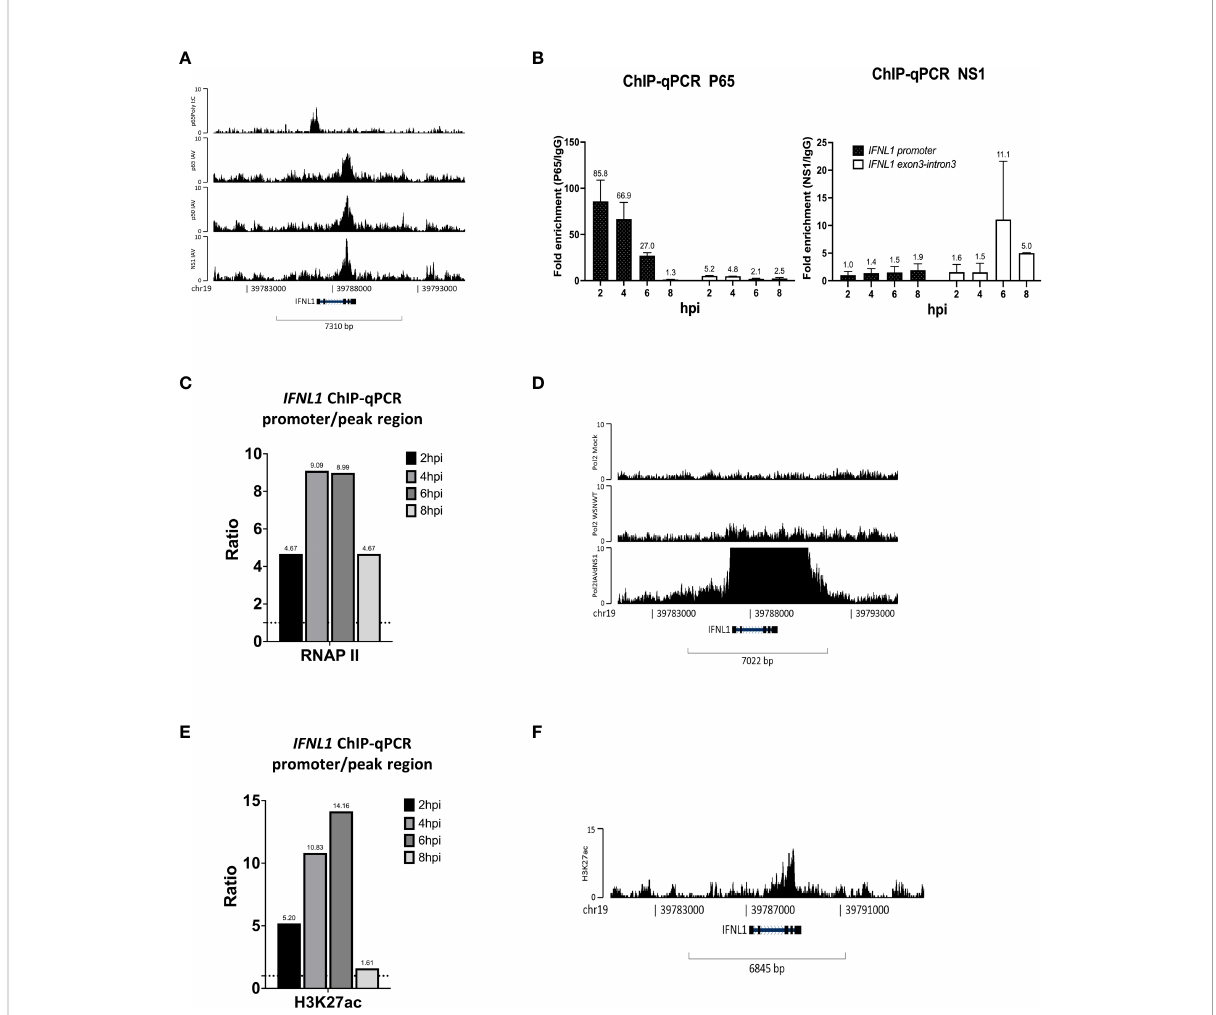
FIGURE 4 NS1 hijacks NF- k B from the IFNL1 promoter to the exon-intron region and attenuates the enrichment of RNA polymerase II and H3K27ac to inhibit IFNL1 expression. (A) Genomic binding of p65 at the IFNL1 gene locus derived from our ChIP-seq data and GSE91018. (B – D) Relative fold enrichment ratios of p65, NS1 (B) , RNA polymerase II (C) , and H3K27ac (D) at the promoter and exon-intron region of the IFNL1 gene locus based on time course analysis. (E) Genomic enrichment of RNA polymerase II at the IFNL1 gene locus derived from the ChIP-seq data (GSE156060) for the mock, IAV, and IAV D NS1 groups. (F) Genomic binding of H3K27ac at the IFNL1 gene loci derived from the ChIP-seq